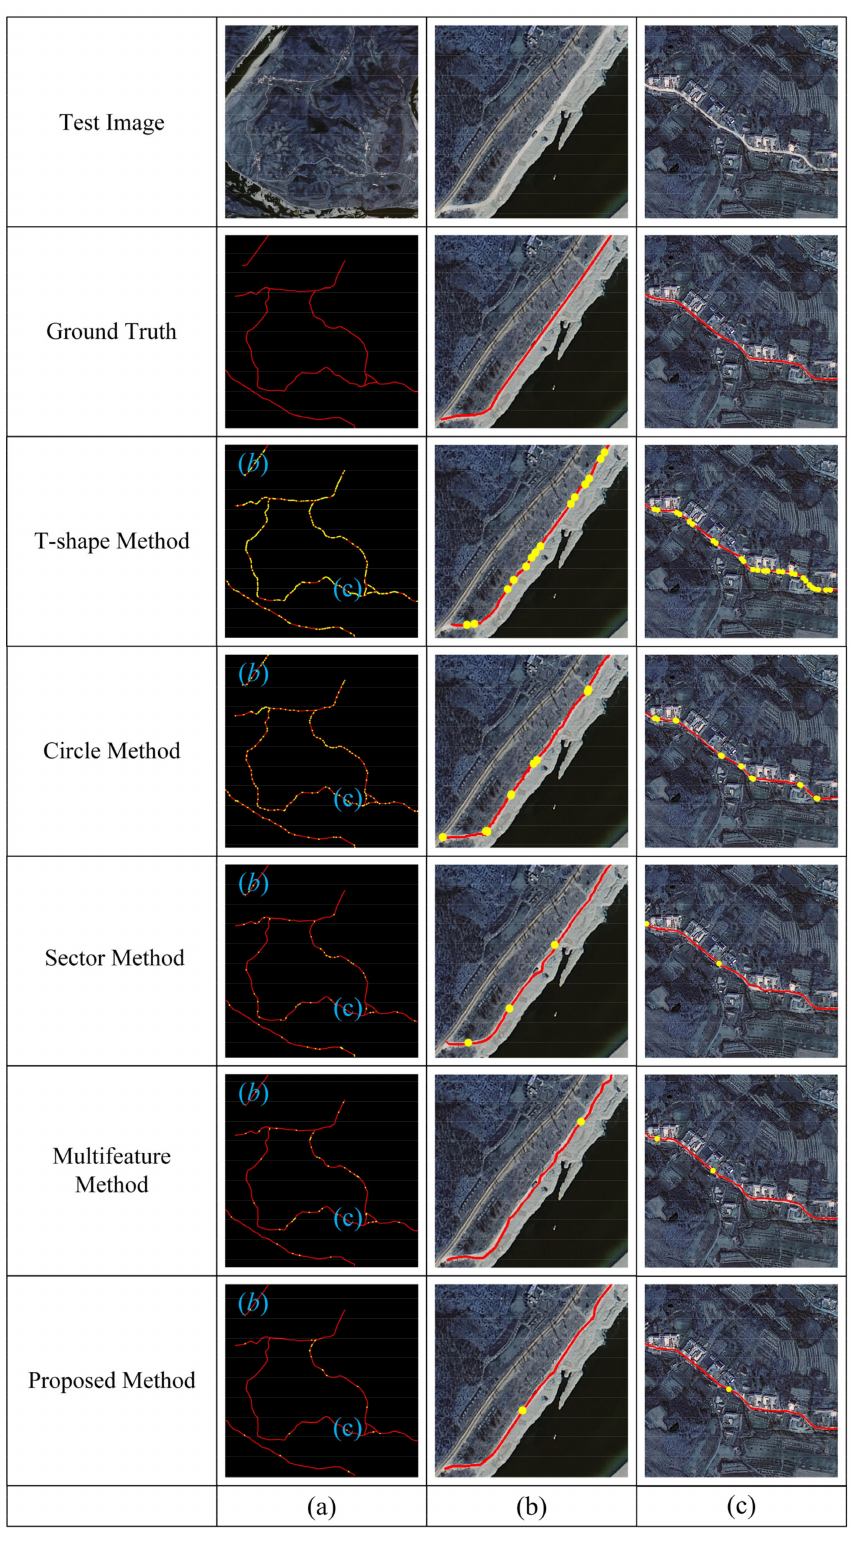
Figure 9. Road extraction results of the five methods analysed in Experiment 3. ( a ) Global graph. ( b ) Local magnification of region b. ( c ) Local magnification of region